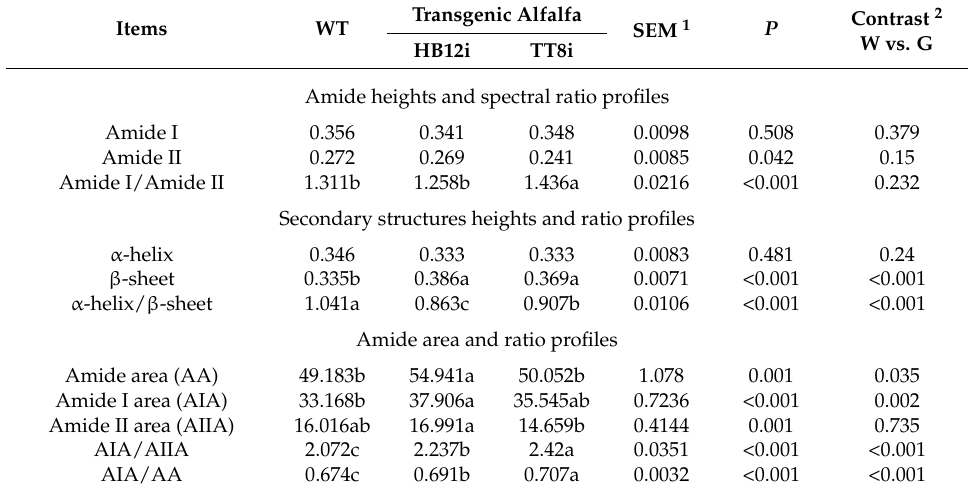
Transgenic Alfalfa